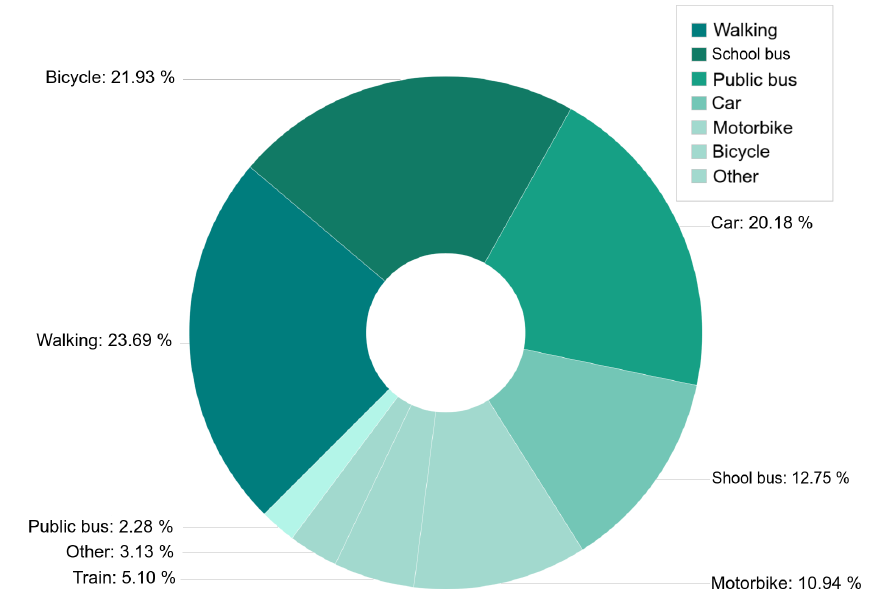
Figure 7. Means of transport preferred by students. The value refers to the total number of respon- dents